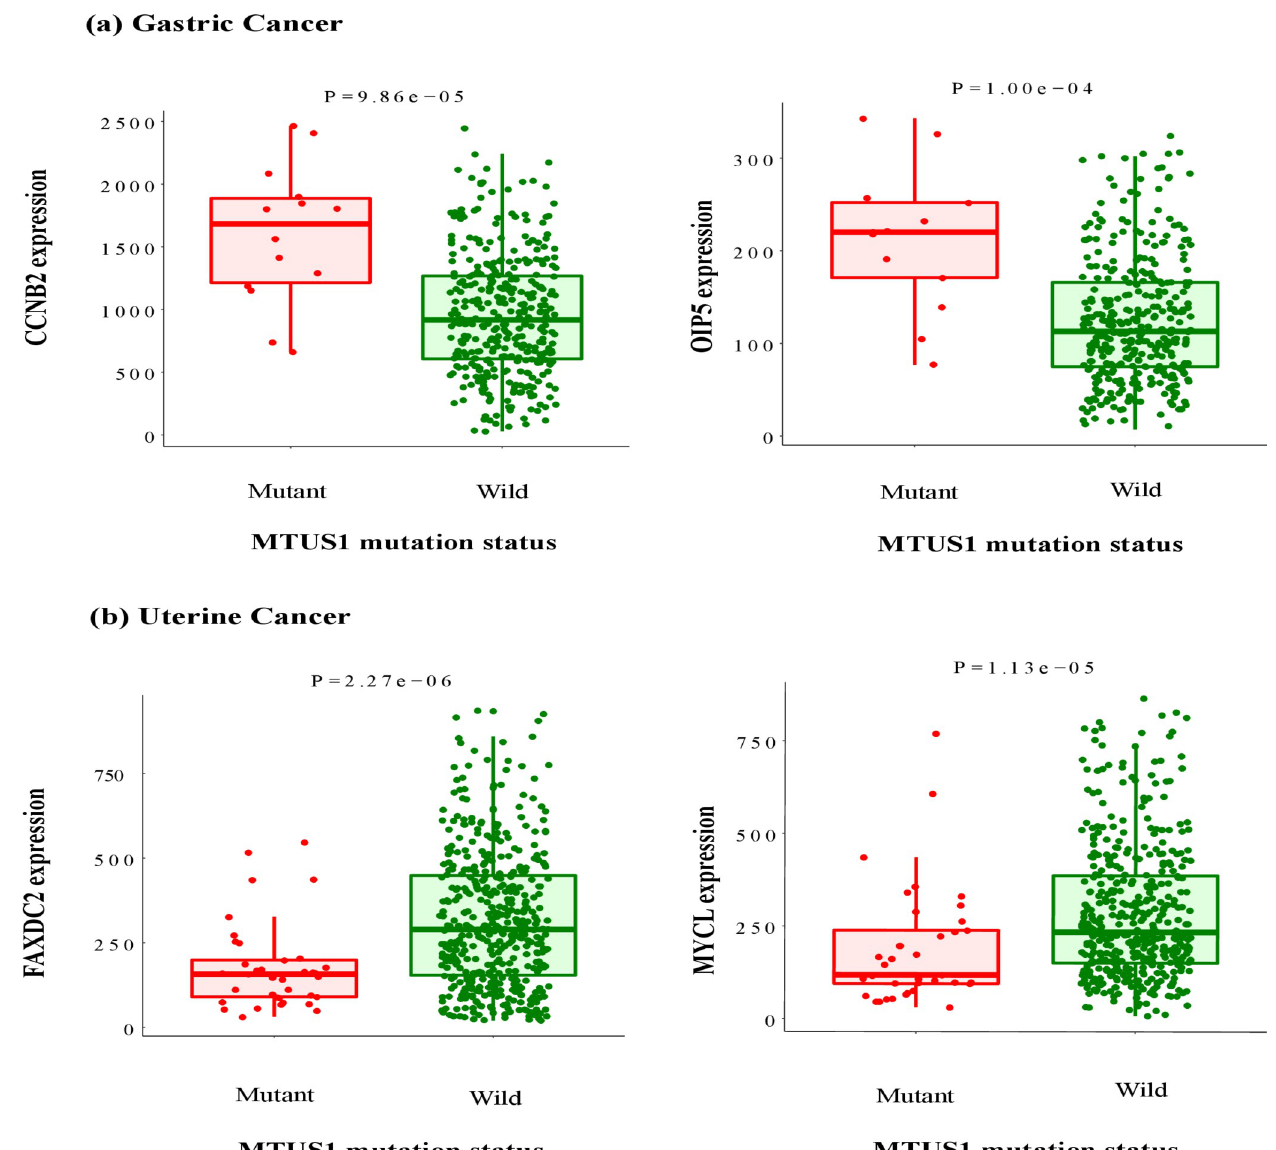
Fig 8. Genotype run for the changes in MTUS1 gene expression; (a) Gastric Cancer (b) Uterine cancer.